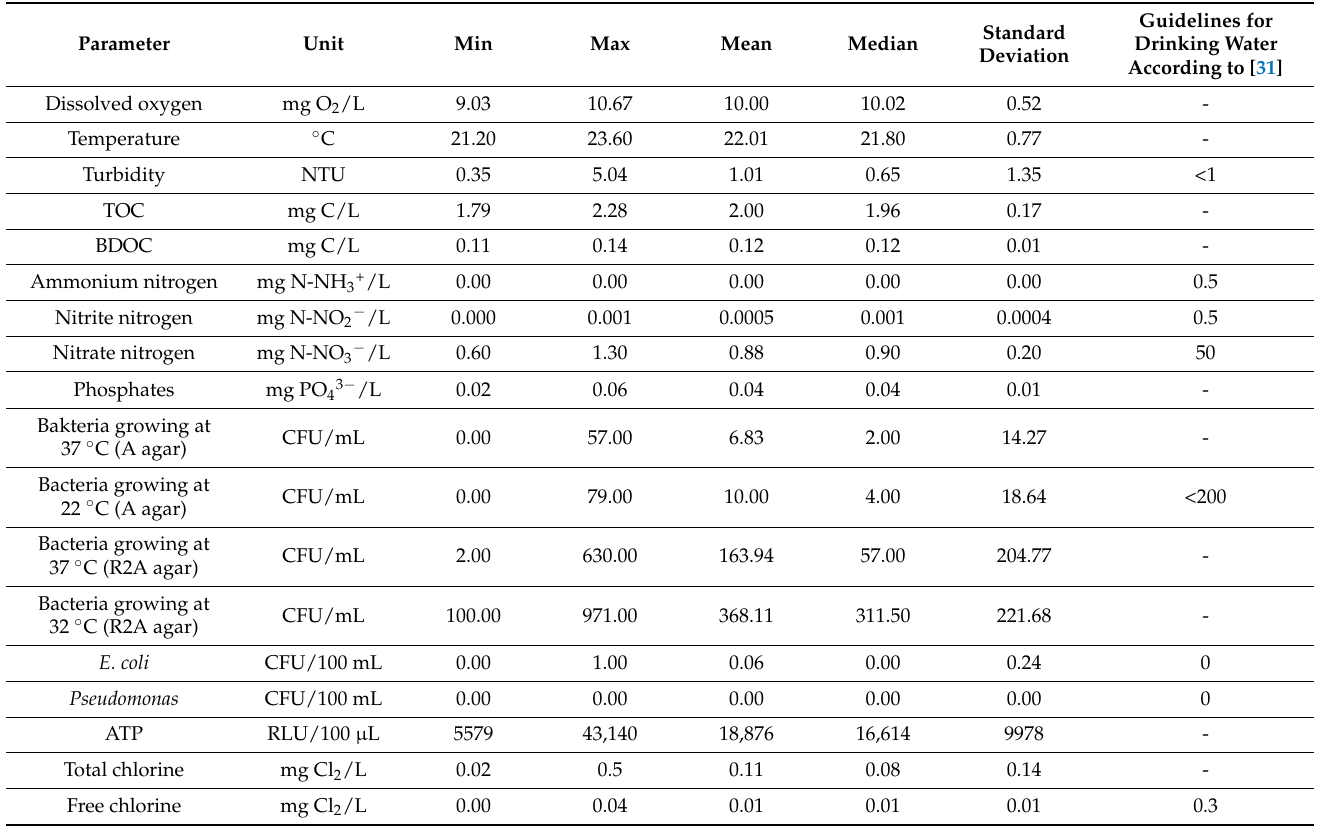
Table 4. The quality of the water flowing into the experimental installation (n =